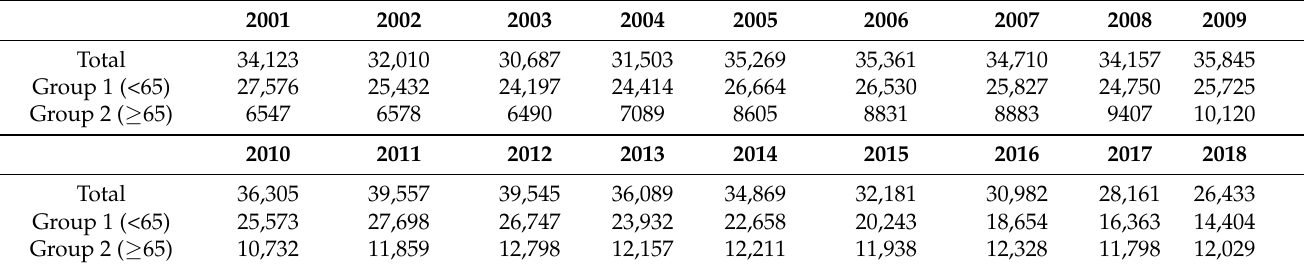
Table 2. Age-specific TB incidence is shown [18–20]; TB incidence among the elderly age group ( ≥ 65 years) is rapidly